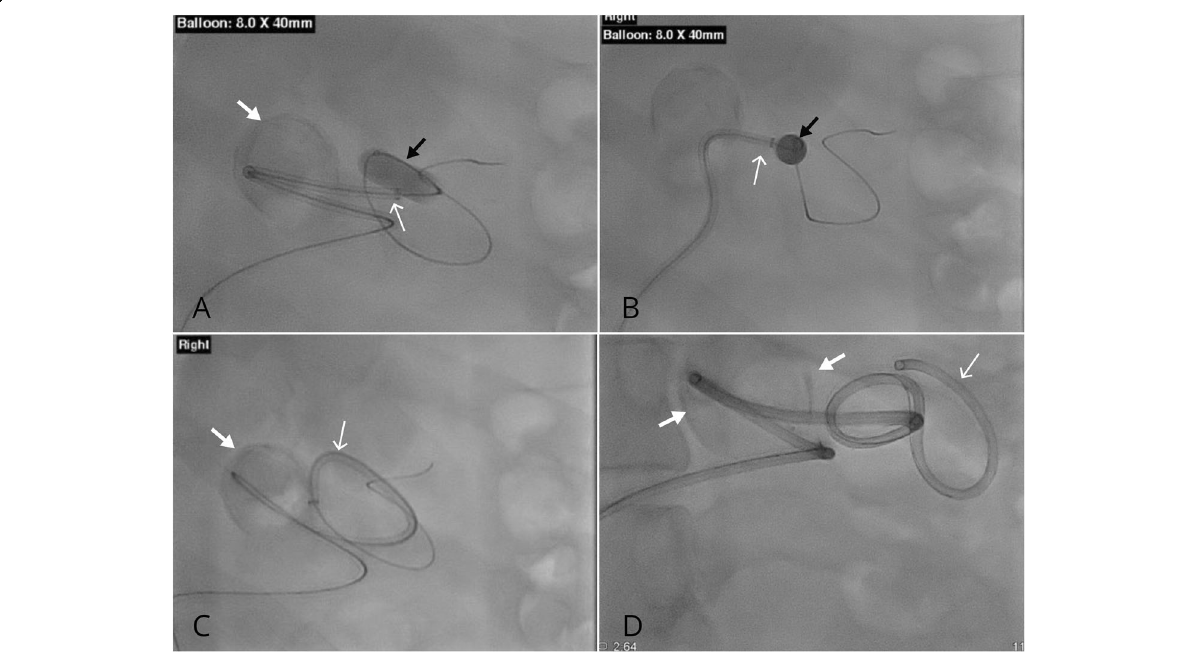
Fig. 2 Balloon anchoring technique. a – d Sequential images demonstrate successful utilisation of the balloon anchoring technique. Initial access was obtained using a 5Fr diagnostic catheter and 0.035 hydrophilic wire. An 8.0 × 40 mm Armada balloon (black arrow) was subsequently inflated and used as an anchor to advance the 6Fr NeuronMAX 088 guide sheath (thin white arrows). Note the partially calcified splenic artery aneurysm (thick white